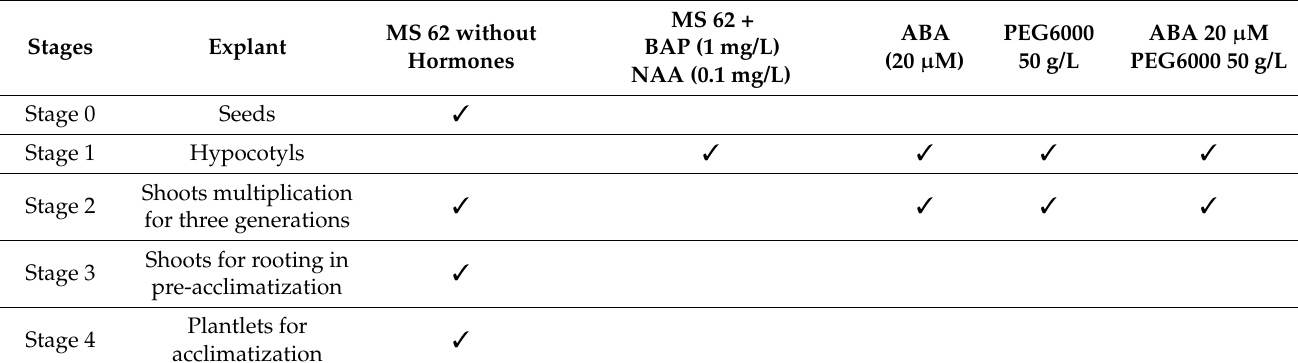
Table 1. Cultivation conditions of Nicotiana tabacum L., “Baladi” to investigate ABA and PEG effects in four experimental stages. The classic Murashige-Skoog culture medium was or not supplemented in different conditions with benzyl- aminopurine (BAP), naphthalene-acetic acid (NAA), abscisic acid (ABA) and polyethylene-glycol 6000